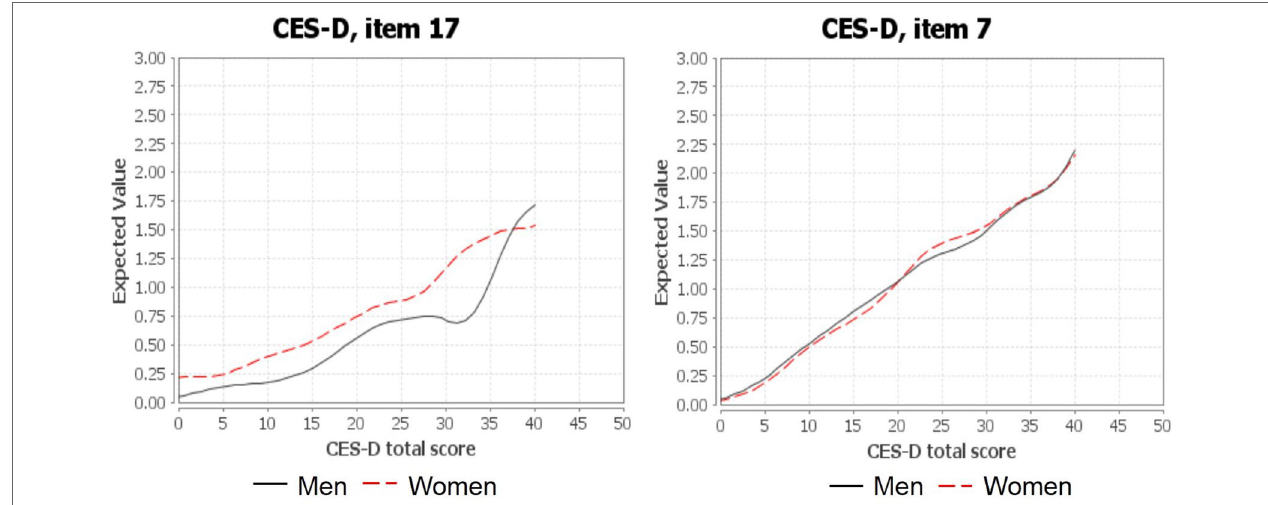
FIGURE 1 | Item characteristic curves for items 17 and